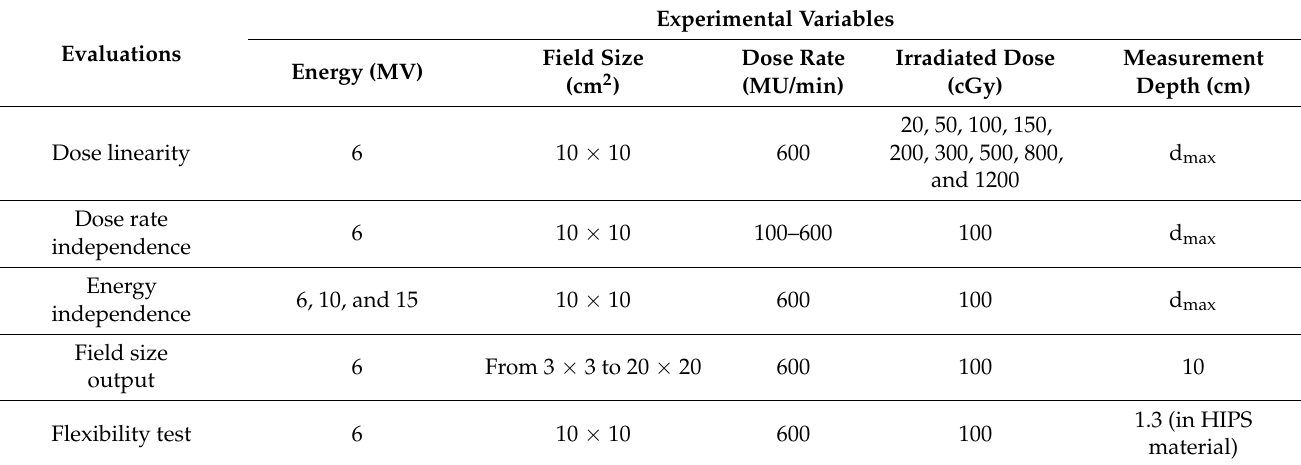
Figure 3. Experimental setup for quantifications/evaluations for dosimetric characteristics of meas- urement system based on a copper indium gallium selenide (CIGS) solar cell. A bolus (flexible/water equivalent material) was used instead of a solid water phantom to reduce airgaps between the solid water phantom and bolus. LINAC and d max denote linear accelerator and depth at maximum dose, respectively. Table 1. Experimental variables to evaluate the dosimetric characteristics of our measurement system based on a copper indium gallium selenide solar cell.